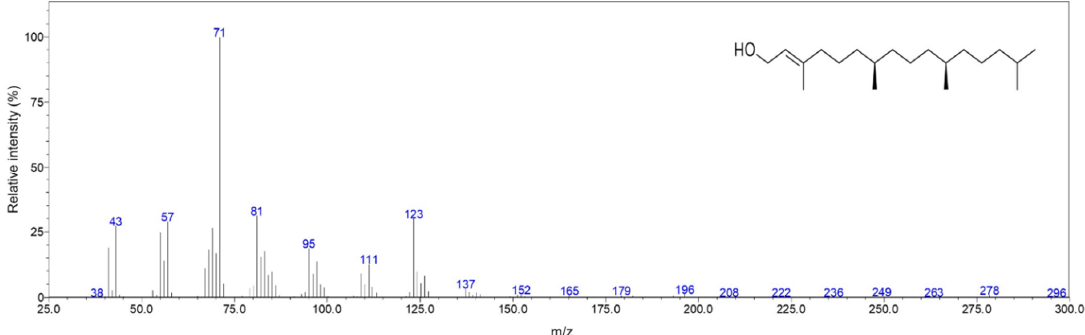
Figure 2. Mass spectrum and chemical structure of phytol found in the present study.